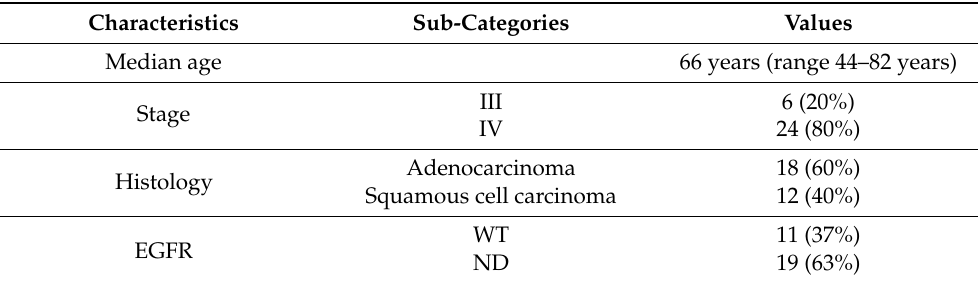
Table 1. NSCLC patients’ clinical characteristics.